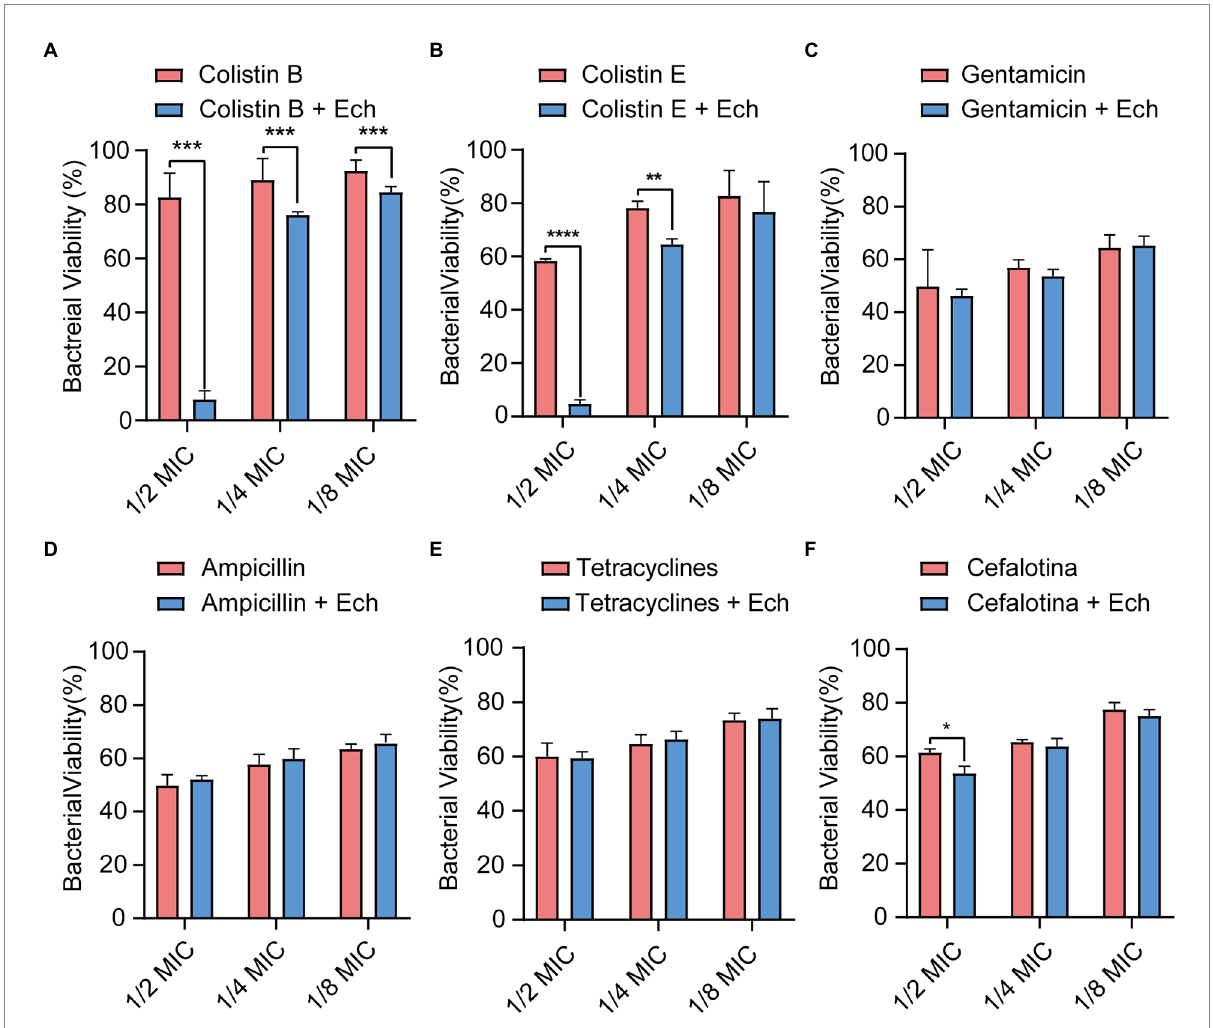
FIGURE 8 Synergistic effects of Ech (50 μ M) with six different antibiotics in E. coli O157:H7 on bacterial viability. Data represent means ± SD of three experiments conducted in triplicate. * = p < 0.05; ** = p < 0.01; *** = p < 0.001;**** = p <